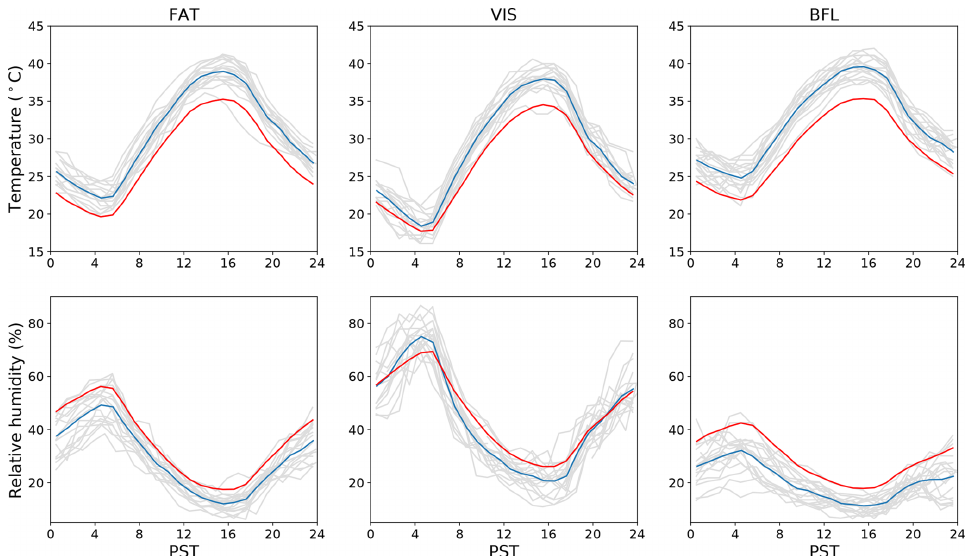
Figure 5. Diurnal plots of temperature and relative humidity during flight days of the Residual Layer Ozone campaign (individual days: grey lines, campaign average: blue lines) compared to 1 June–30 September 2015 and 2016 averages (red lines) at the Fresno (FAT), Visalia (VIS), and Bakersfield (BFL) airports as part of the Automated Weather Observing System (AWOS) network. Hours are in Pacific Standard Time